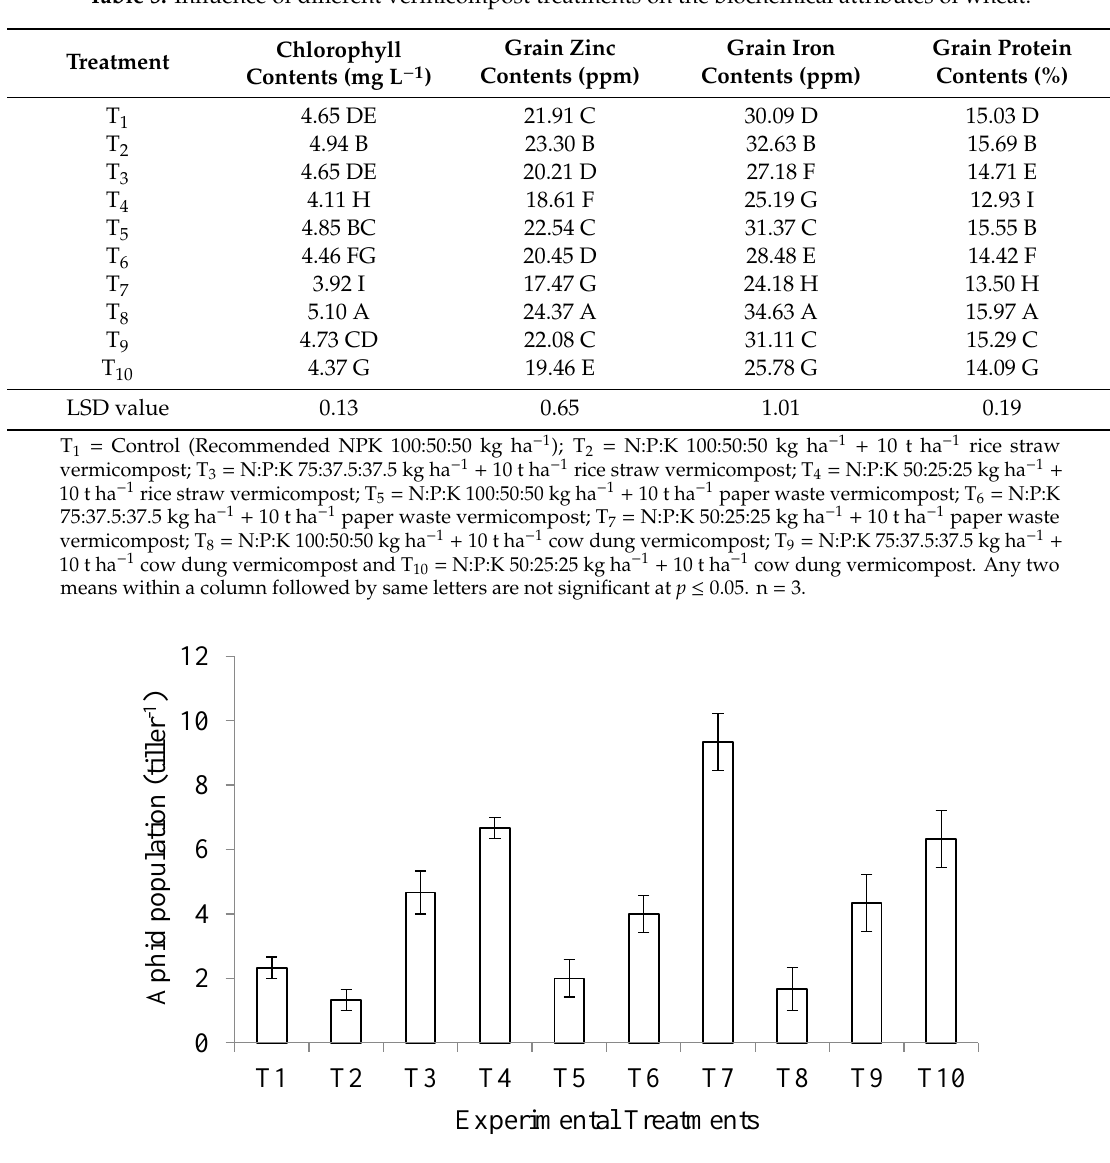
Figure 1. Aphid population as affected by the use various fertilizer and vermi-compost treatments.